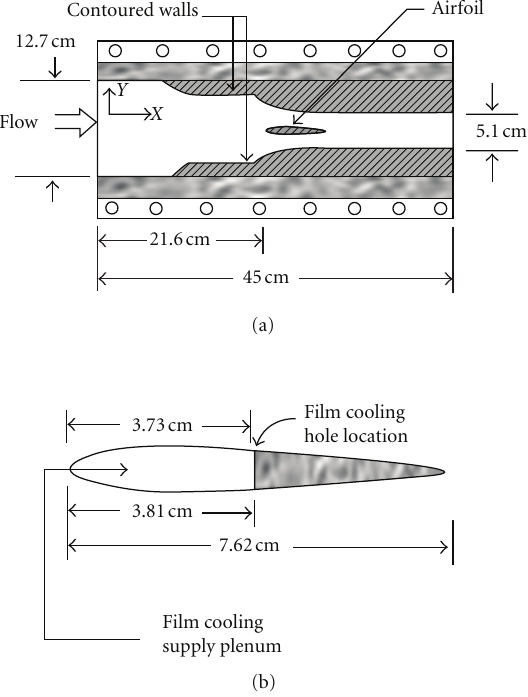
Figure 8: Schematic diagrams of the (a) test section, and (b) test airfoil, for the investigations utilizing symmetric airfoils with film cooling